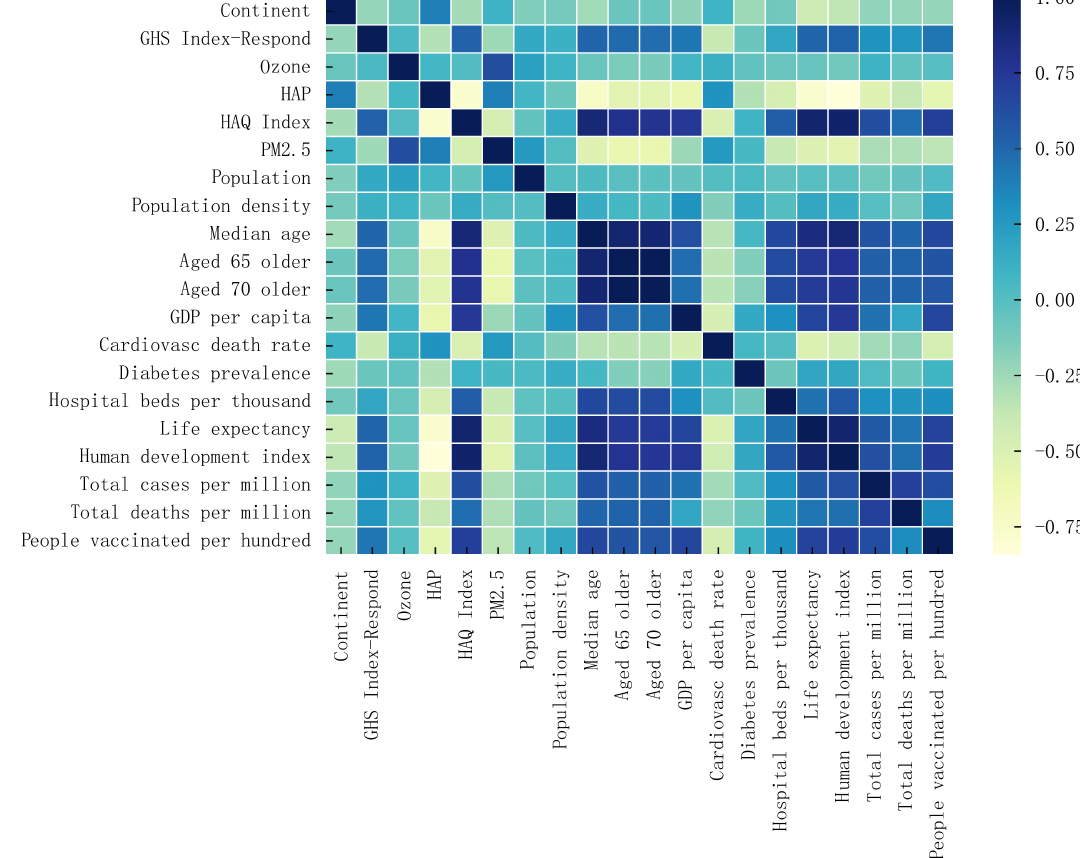
Fig. 6 Heat map of correlation coefficient matrix. The dark blue color indicates the nearness of the correlation coefficient to 1 between the variables and a strong positive correlation; conversely, the negative correlation is strong when the correlation coefficient is near